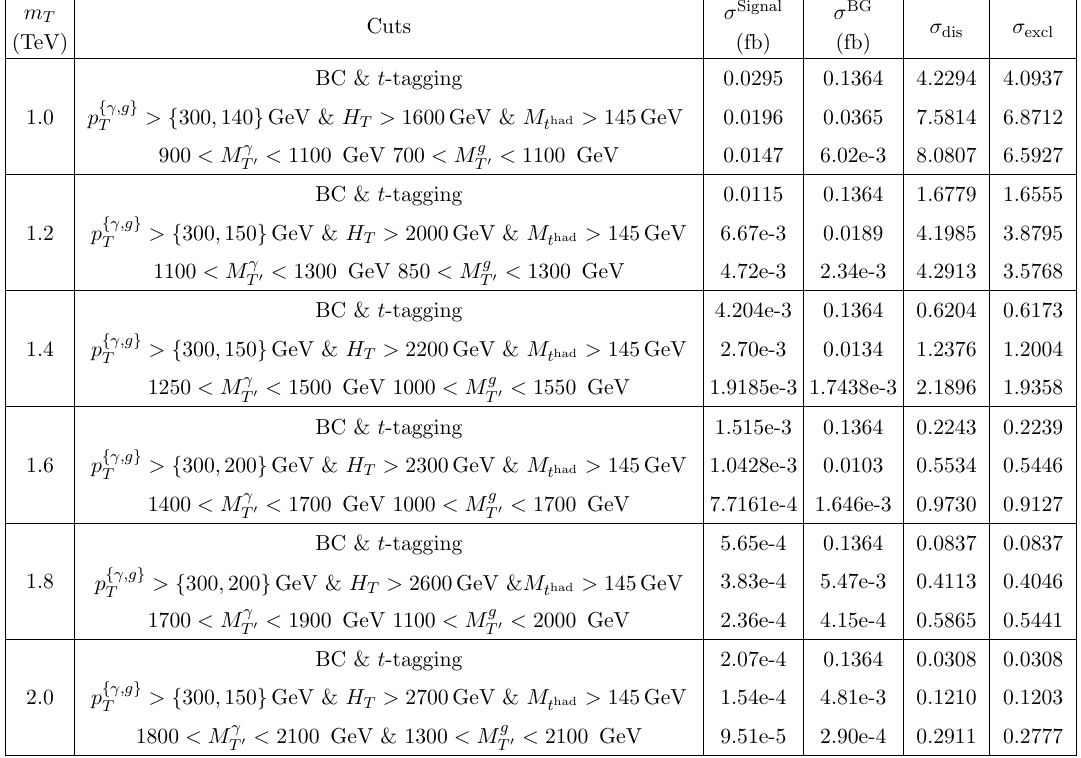
Table 7 . The same as table 6 but for the ttg(cid:13) channel. Open